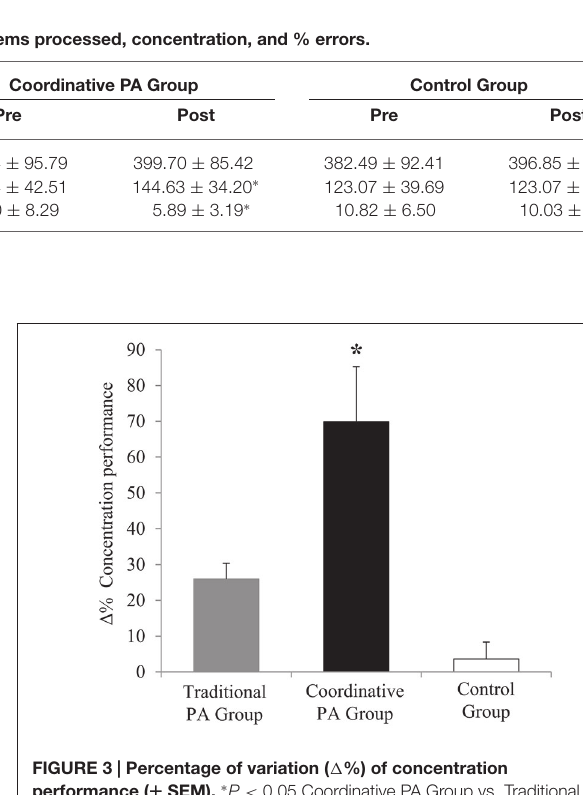
FIGURE 1 | Percentage of variation ( ∆ %) of the total number of items processed ( ± SEM). * P < 0.05 Traditional PA Group vs. Coordinative PA Group.